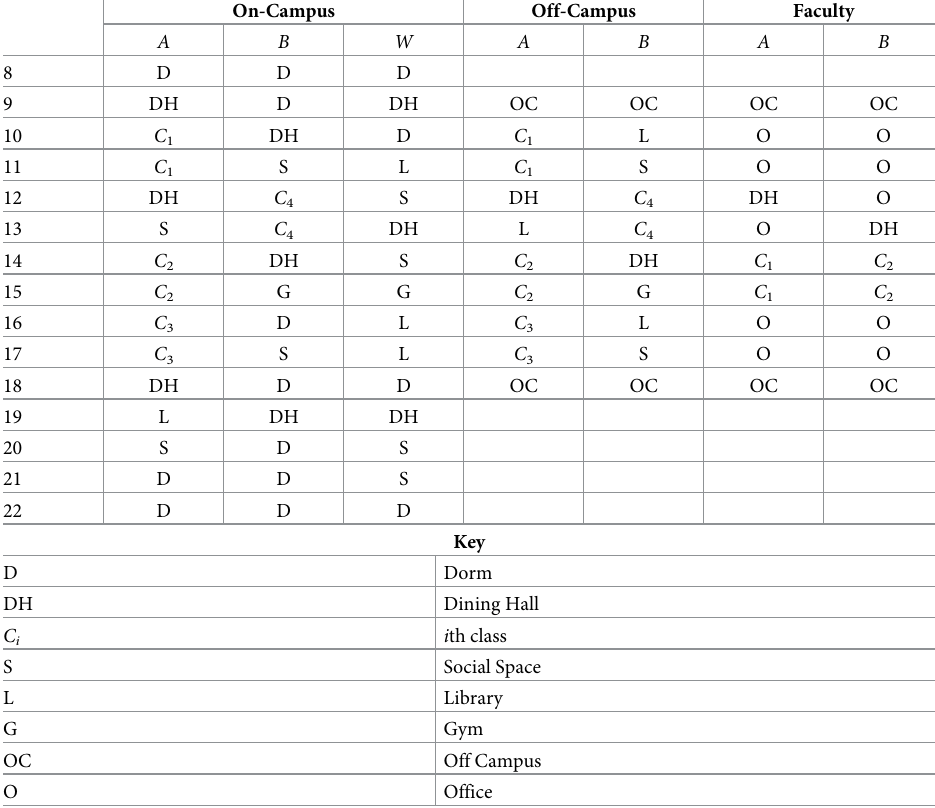
Table 1. Sample schedules for an on-campus student, an off-campus student, and a faculty member. Each row is the time of day.